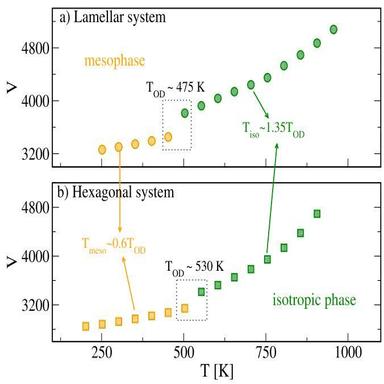
System volume for different temperatures. The jump in volume indicates the order-disorder transition at . The regions are color-coded: temperatures represented in yellow indicate the mesophase, while those in green denote the isotropic phase. In (a), the lamellar system is shown, and in (b), the hexagonal system. For both, specific temperatures are set to study the mesophase at meso = 0.6 and to investigate the isotropic phase structurally at a temperature above the transition, iso = 1.35.